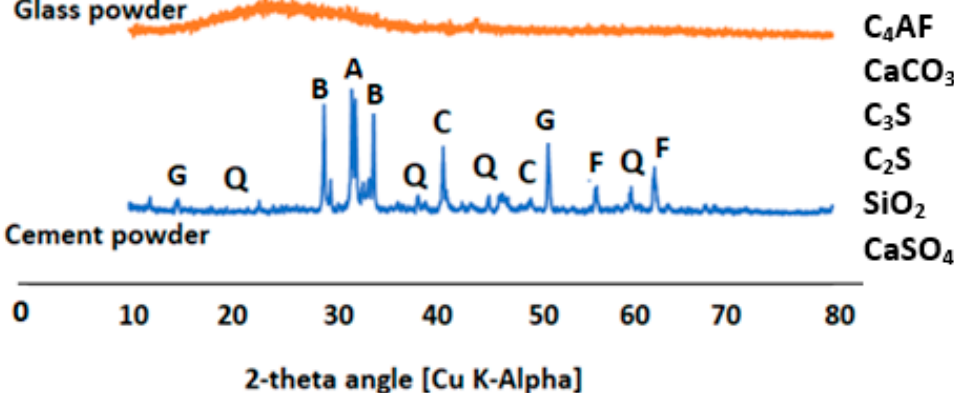
Figure 2. XRD diffractogram of the glass waste and cement powder. The specific surface areas (BET) of WGP were determined using Micromeritics ASAP2020 via nitrogen gas adsorption. The morphologies of WGP and cement powder were evaluated using a JSM-5800LV scanning electron microscope (Figure